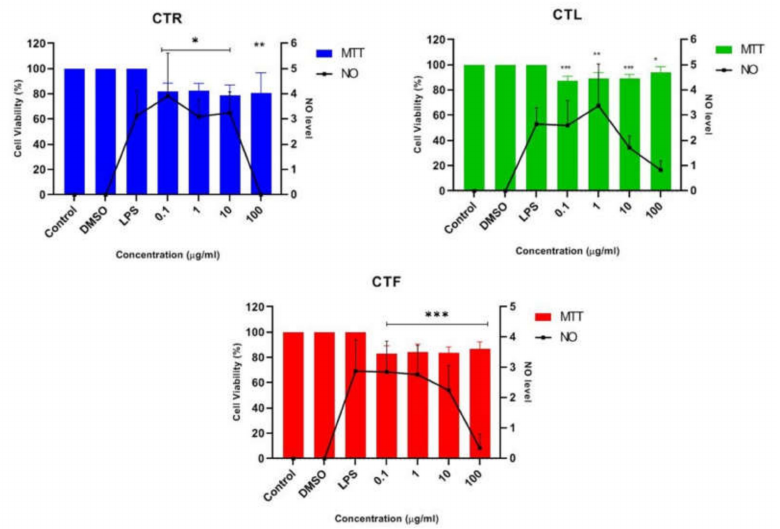
Figure 3. Effect of CTR, CTL, and CTF extracts on NO production in LPS-induced BV-2 cells for 24 h. The NO level is denoted as mean values ± SD, and n = 3. The extract showed dose-dependent inhibition of NO release. The value is statistically significant * ( p < 0.05), ** ( p < 0.01), and *** ( p < 0.001) when compared with LPS